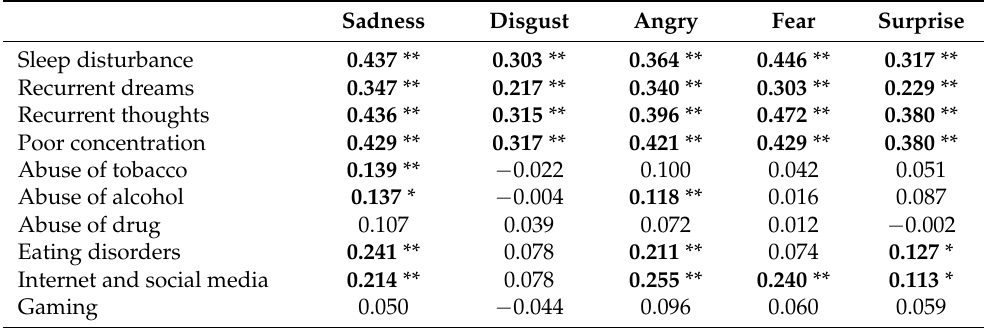
Table 3. Association between change in intensity levels of each emotional cluster and unhealthy